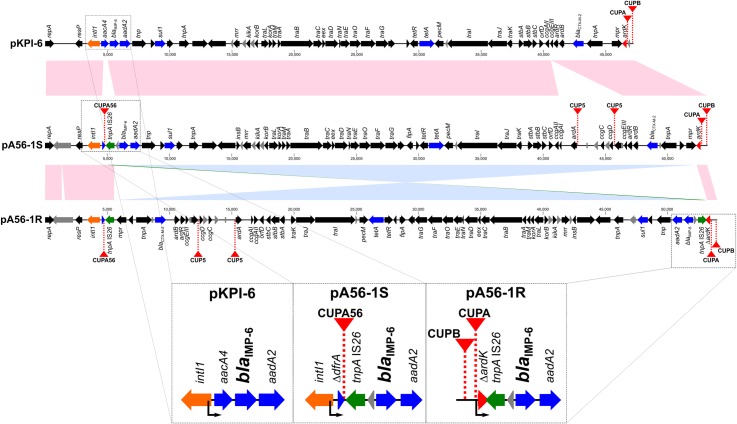
Schematic representation and pair-wise alignment of the blaIMP-6-positive plasmids pKPI-6, pA56-1S, and pA56-1R.The sequences of pA56-1S and pA56-1R were compared with the sequence of pKPI-6. The gene clusters of pA56-1S and pA56-1R were identical, with the exception of an additional IS26 insertion in ardK on pA56-1R and subsequent inversion of the additional IS26 sequence. The colored boxes indicate homologous regions with 100% nucleotide identity. Pink, the same orientation; blue, inversion; green, inverted insertion of an additional IS26 element. Notable genes are represented by red, ardK; orange, integrase; green, IS26; blue, antimicrobial resistance genes; gray, hypothetical protein. Red arrowheads indicate conserved upstream (CUP) sequences which represent ArdK binding sites. Bent arrows indicate promoters upstream of blaIMP-6.